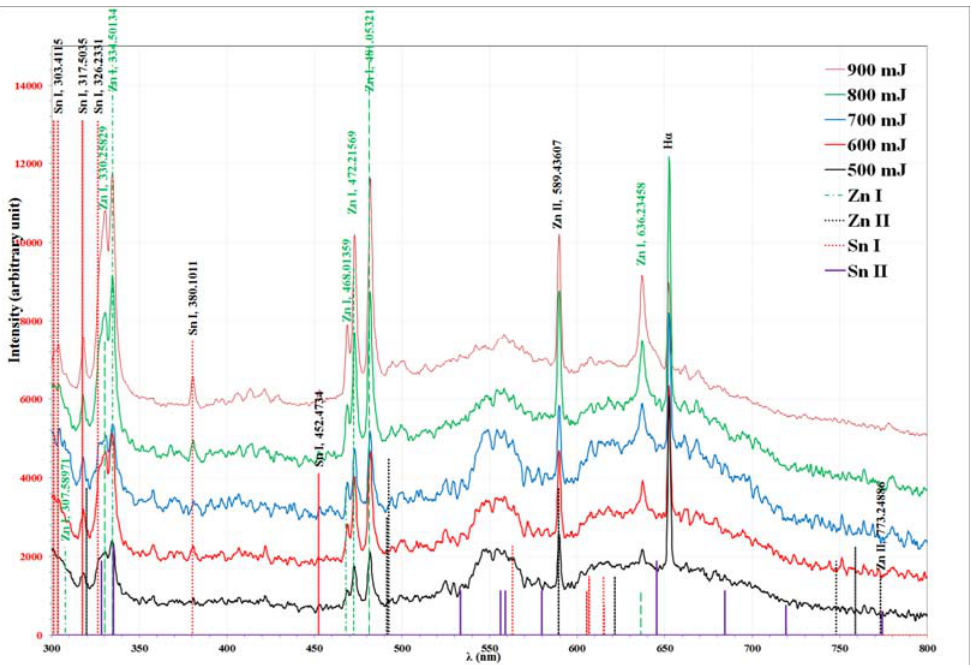
Fig.2 (a): Spectroscopic patterns for plasma emission from X= 0.2 SnO different laser